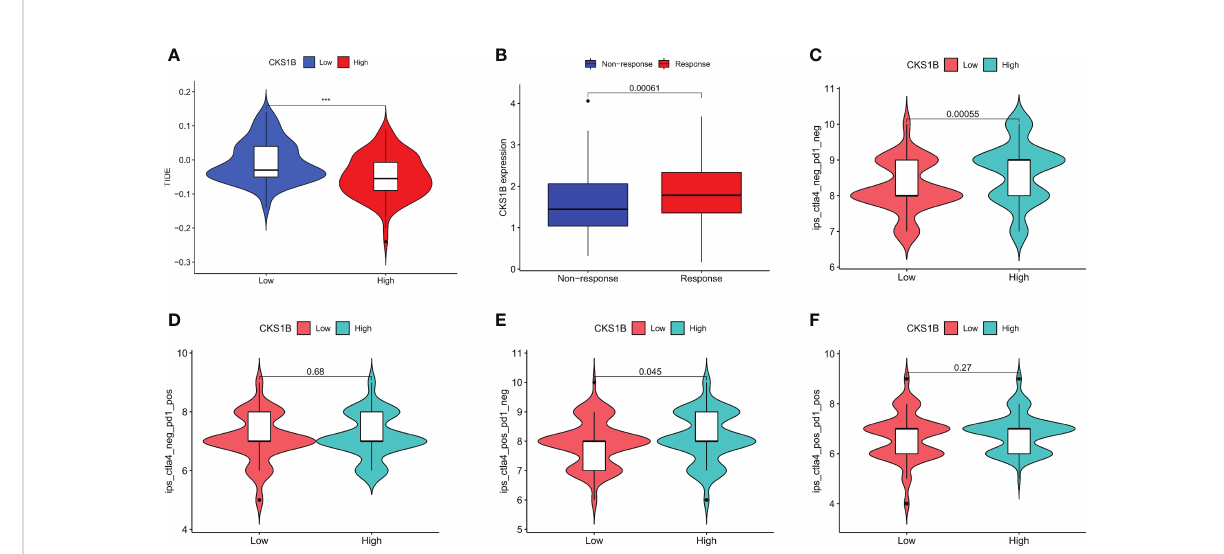
FIGURE 7 CKS1B is positively associated with ef fi cacy of immunotherapy in pancreatic cancer. (A) The TIDE score in high CKS1B and low CKS1B groups. (B) The comparison of bene fi ciaries from immunotherapy between the high- and low-CKS1B group. (C – F) Correlation analysis between immunophenoscore of anti-CTLA-4 and anti-PD-1 blocker and CKS1B eexpression.